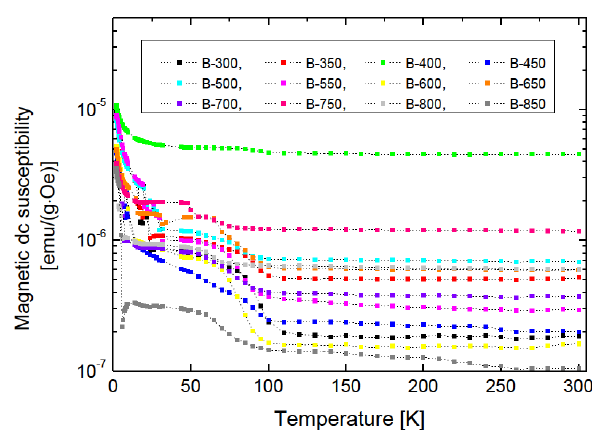
Figure 1 presents temperature dependence of dc magnetic susceptibility, defined as χ = M/H , where M is magnetisa- tion and H an external magnetic field, for all investigated samples measured in FC mode in an external magnetic field H = 100 Oe. The vertical axis is in logarithmic scale for better separation of χ ( T ) curves and to see them more clearly. The general form of all χ ( T ) curves is the same for all samples: they could be seen as composed of at least three very different components: